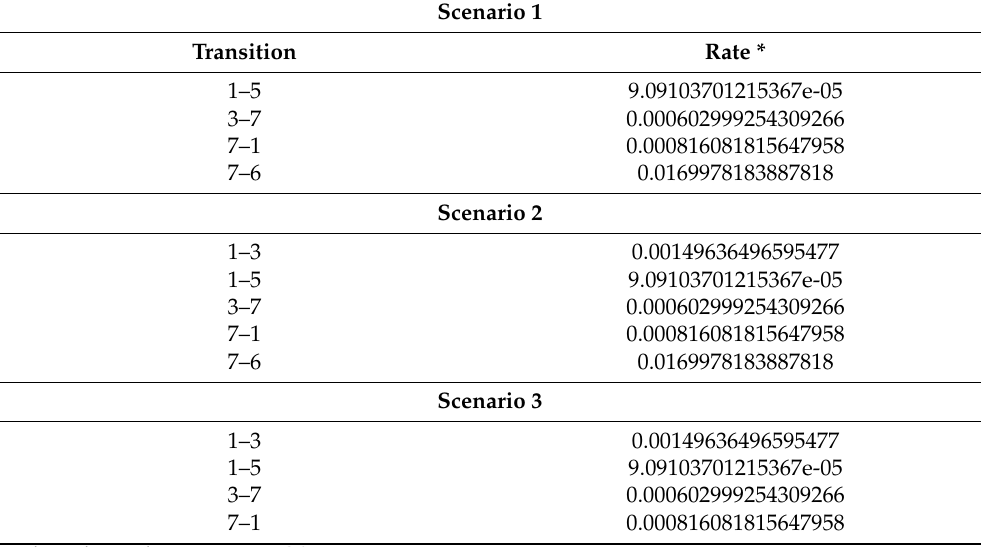
Table 7. Multiple step transition matrices for Scenarios 1, 2, and